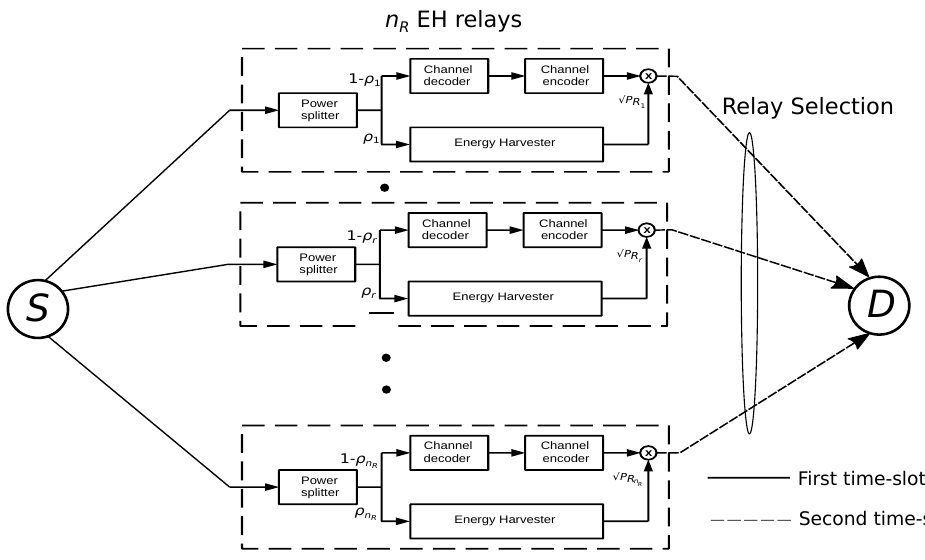
Figure 1. Coded cooperative network with multiple energy-harvesting